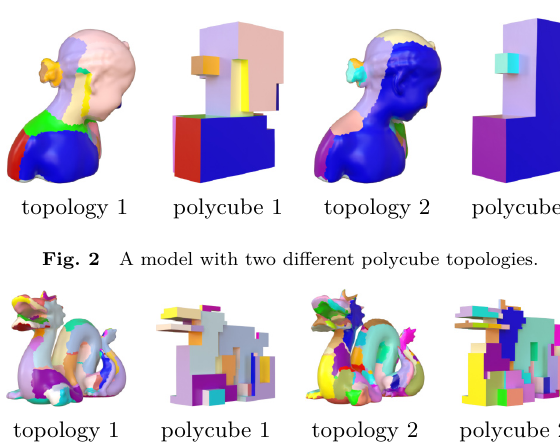
Fig. 3 Another model with two different polycube